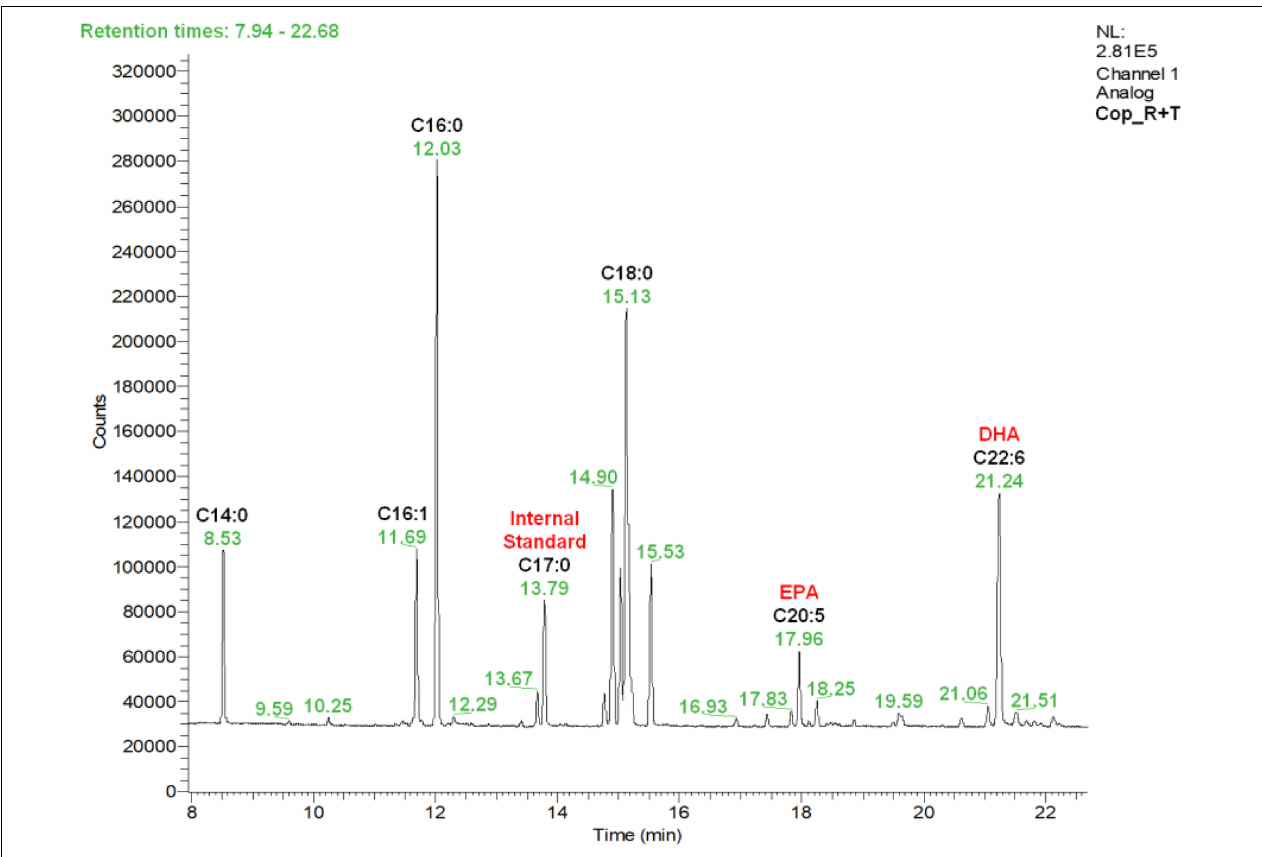
FIGURE 1 | Fatty acid profile obtained by gas chromatography (GC) in Paracyclopina nana copepods fed with the microalgal diet R + T. Respective rentention times for each peak appear in green. Peaks corresponding to the identified fatty acids and the internal standard are annotated in bold black. R, Rhodomonas salina; T, Tisochrysis lutea